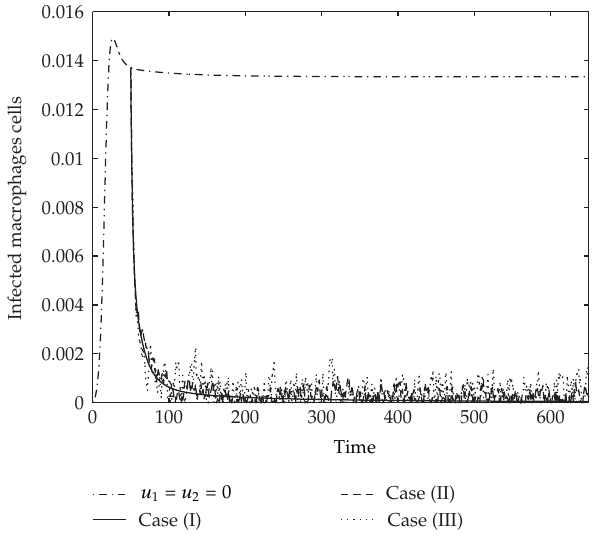
Figure 4: The evolution of infected macrophages.